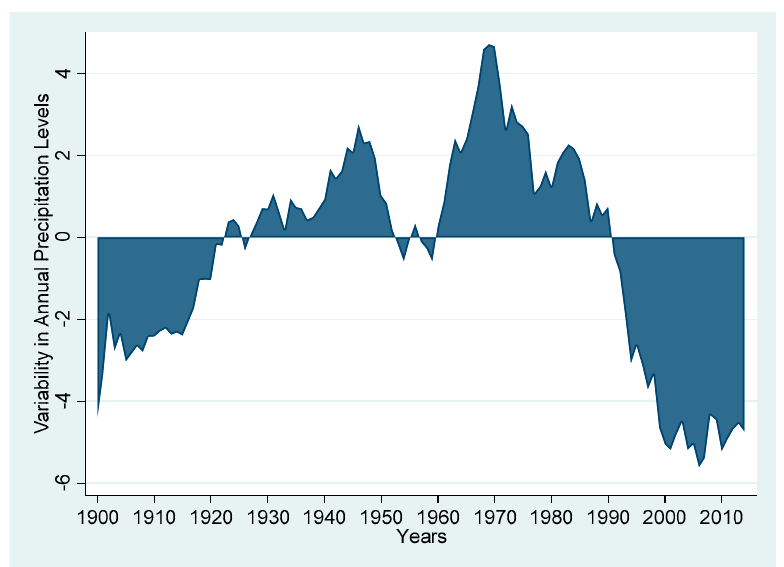
Figure 3. The 31-year moving average of the annual deviation from the long-term precipitation levels across India from 1900 to 2012.